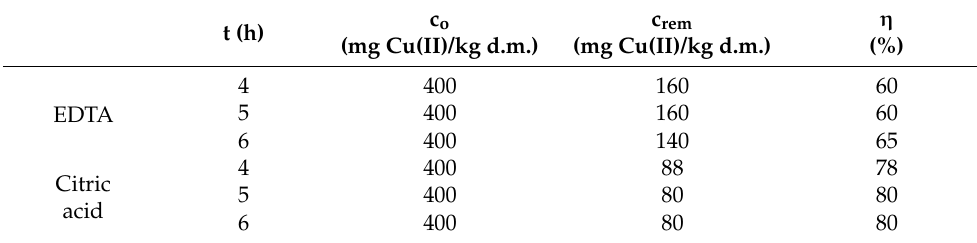
Table 4. Results of Cu(II) removal from sediment.